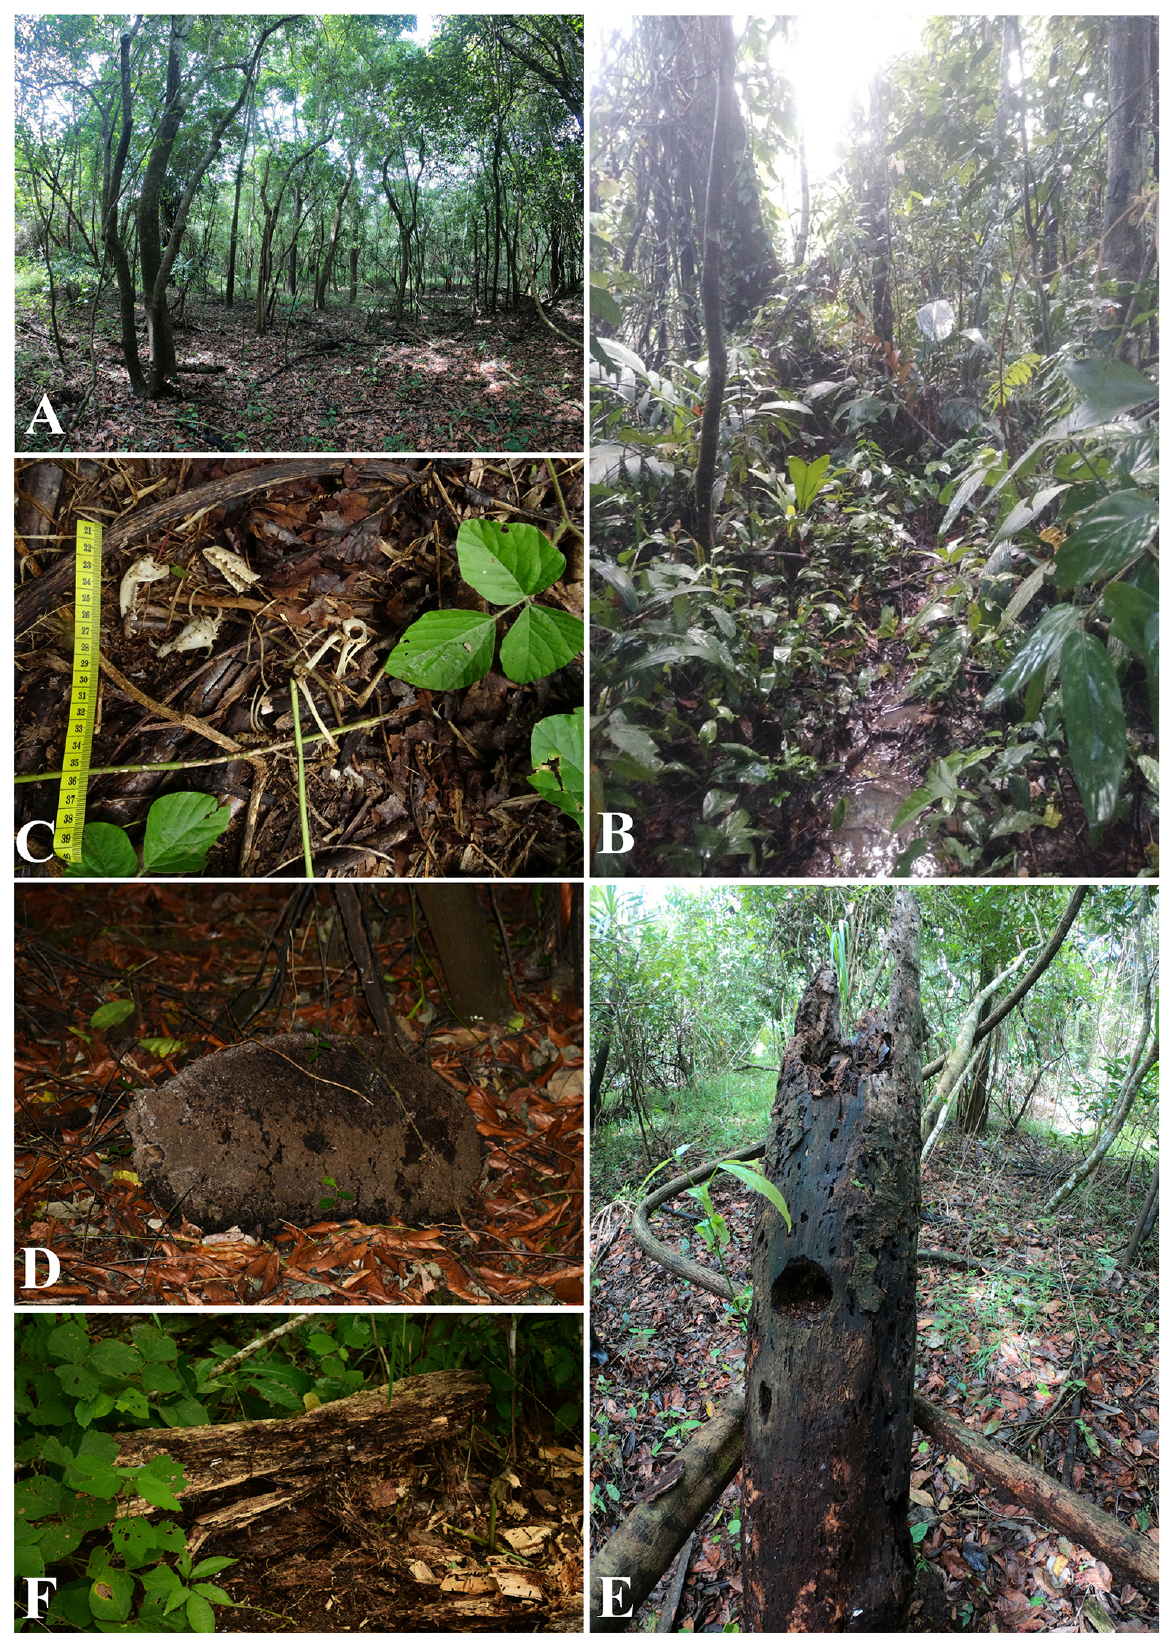
Figure 2. Photos of the habitats in the collection sites: A , Meandric floodplain (Nueva Alianza); B , low hill forest (Nuevo Sucre). Microhabitats: C , Philander sp. skull; D , decayed termite nests; E, F , rotten